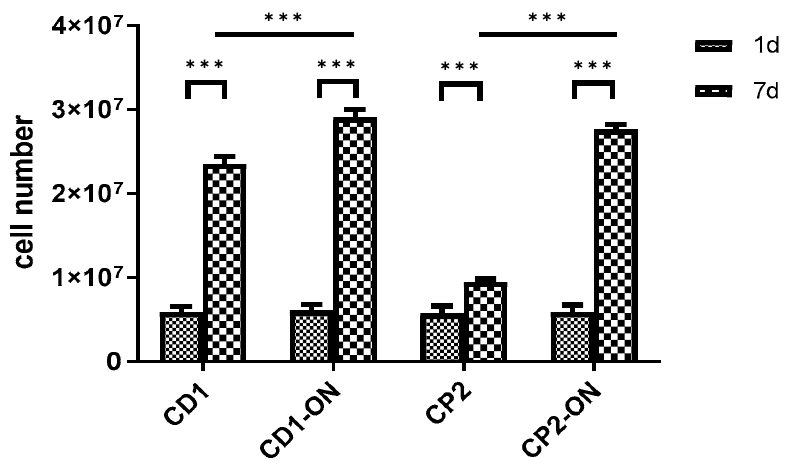
Figure 10. Changes in the number of viable DPSCs cultivated with Cytodex 1 (CD1) or Cytopore 2 (CP2) under dynamic cultivation in shake flasks for 7 days. Half of the flasks (CD1 and CP2) were immediately shaken in an incubator. The other half of the flasks (CD1-ON and CP2-ON) were left still in the incubator overnight before shaking started, to promote cell adhesion to the microcarriers. Values are means ± SEM ( n = 5). *** p < 0.001 in comparisons as indicated.